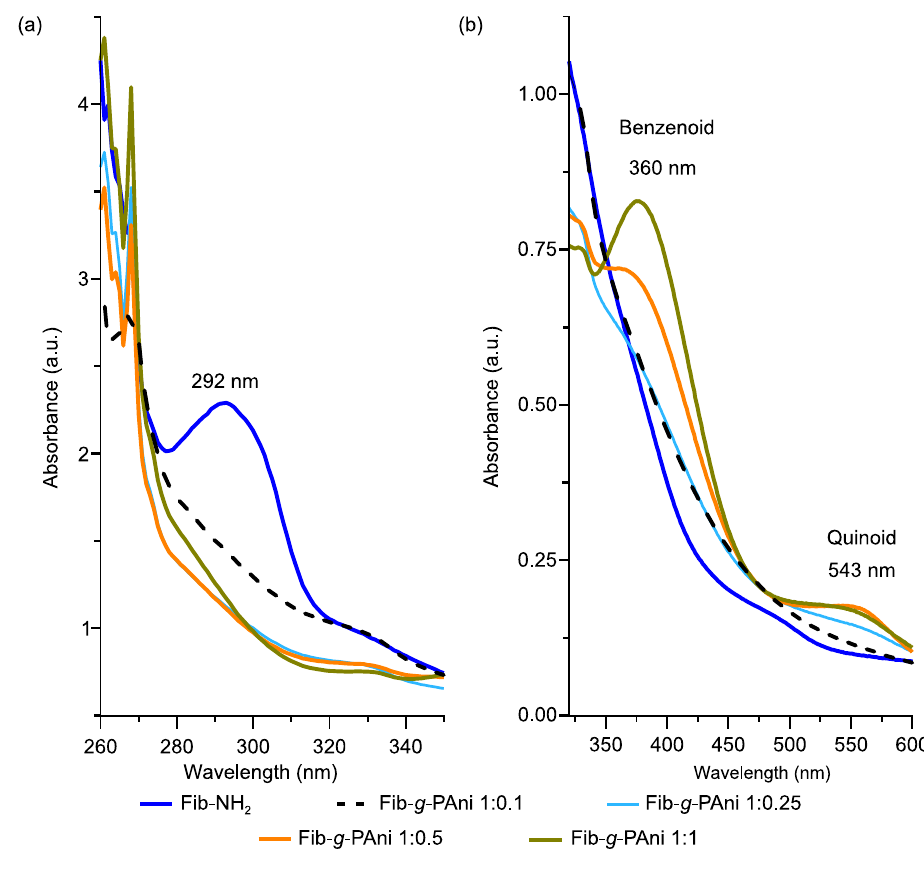
Figure 4. UV-Vis spectra of Fib-NH 2 and Fib- g -PAni copolymers ( a ) UV-Vis spectra from 260 to 350 nm and ( b ) UV-Vis spectra from 340 to 600 nm.